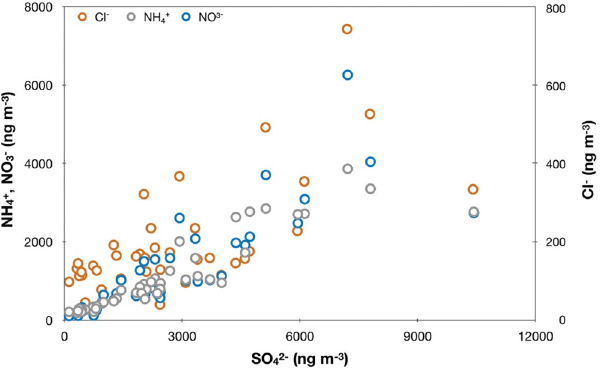
Figure 2. Scatter plots of Cl − , NO 3 − , NH 4 + versus SO 42 − . The respective R 2 values are 0.47, 0.70, and 0.83, respectively. The p -values are all less than 0.001.